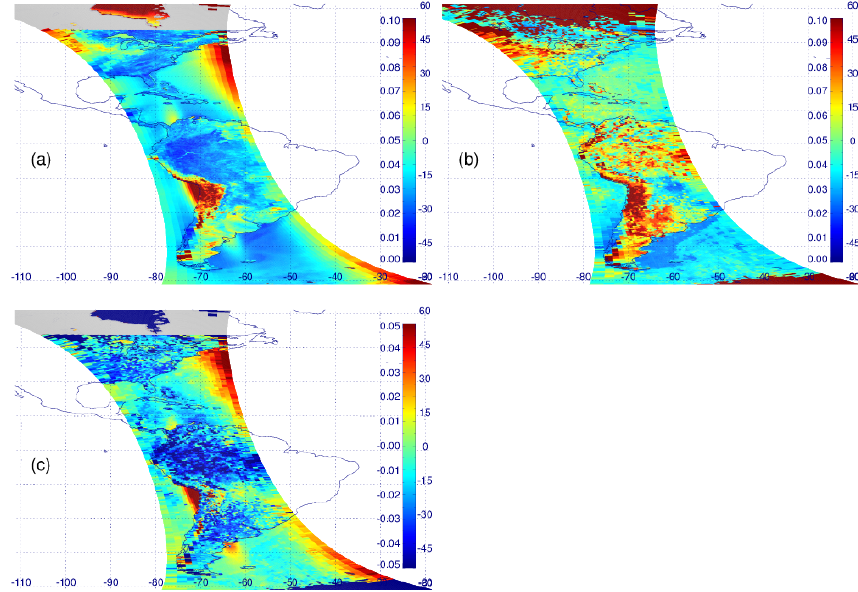
Figure 3. (a) LERs computed at 466nm for OMI orbit 12414 of 14 November 2006 using MODIS-based BRDF with OMI geometry, (b) OMI-based monthly climatology, and (c) their difference: MODIS-based minus climatological LERs. Missing MODIS BRDF data are shown in grey here and